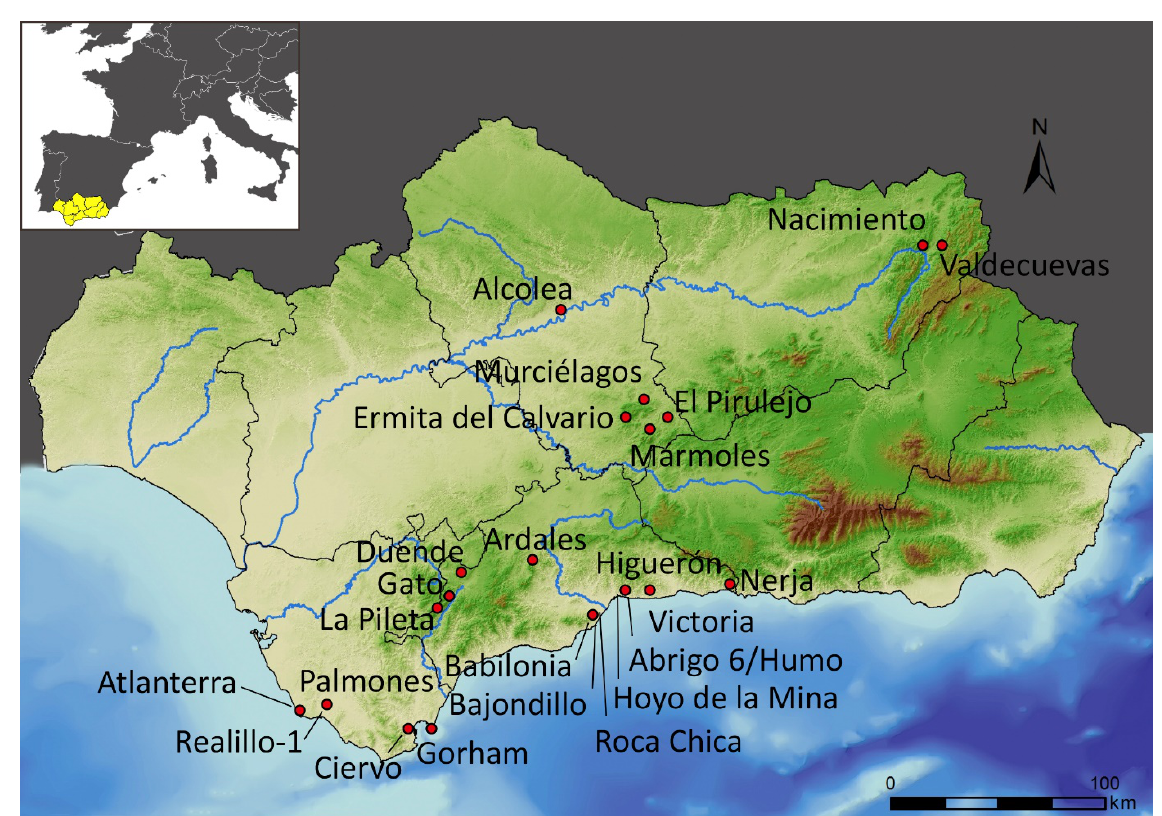
Figure 14. The site spread in the south of